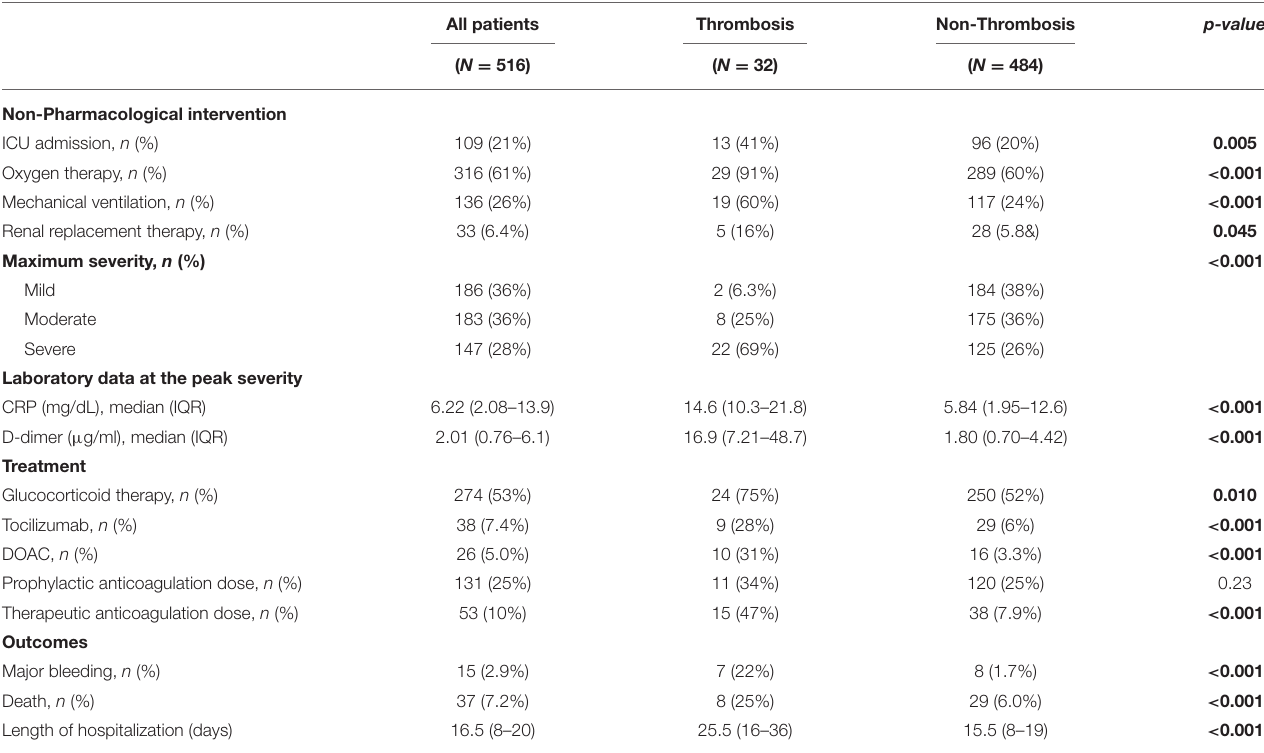
TABLE 4 | Clinical course of the first cohort patients complicated with or without thrombosis. All patients Thrombosis Non-Thrombosis p-value